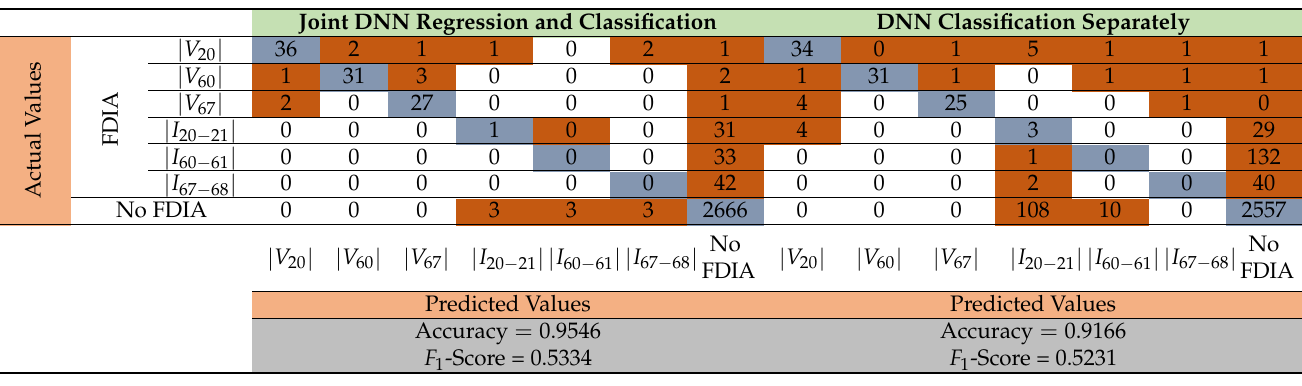
Table 5. Confusion Matrix Showing Bad Data Detection Results and Accuracy Values Obtained Using the Proposed Method and the Binary Classification-only DNN Model when N a = 876,